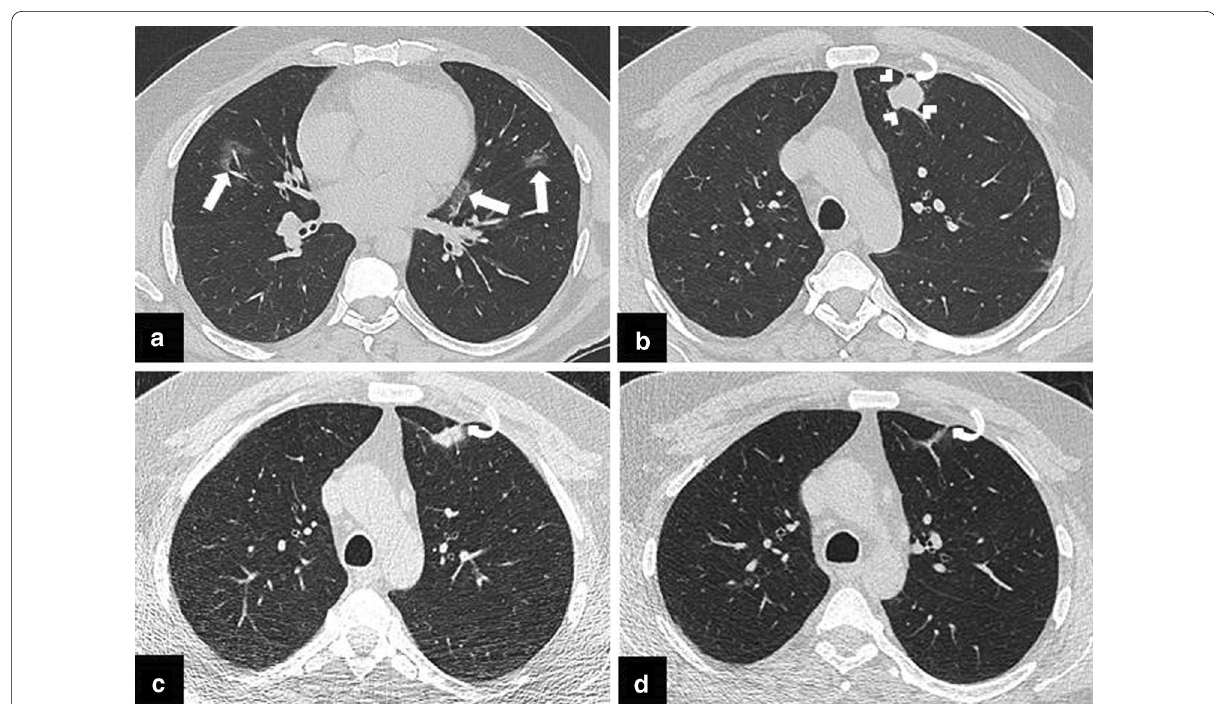
Fig. 1 a , b The initial chest CT scan obtained following PCR test positivity for COVID-19 infection, revealed a few patchy areas of ground glass opacity (GGO) in both lungs (arrows) compatible with COVID-19 pneumonia. An irregularly shaped solid nodule 2 cm in diameter in left upper lobe of the lung was also noted (arrowheads). Percutaneous transthoracic core needle biopsy was scheduled due to suspicion of primary lung cancer. c CT scan obtained prior to biopsy procedure demonstrated significant size reduction of the nodule. Therefore, biopsy was not performed. d Follow-up CT scan obtained 3 months later demonstrated complete resolution of the nodule. A pleural tag which became more apparent following resolution of the nodule (curved arrows, b – d ) raised the suspicion of COVID-19 triggered focal organizing